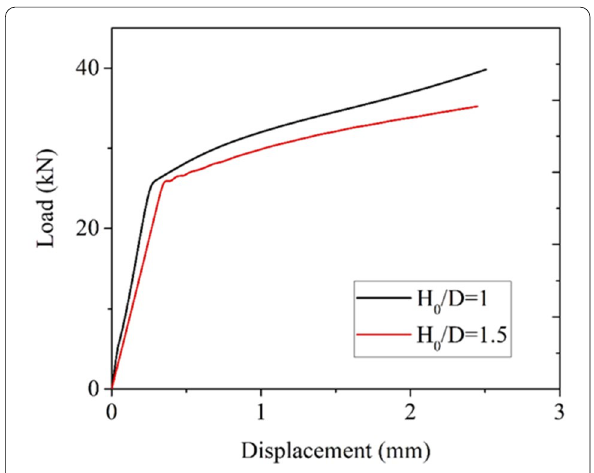
Figure 5 Force–displacement relationship of compression specimens with different height-to-diameter ratios